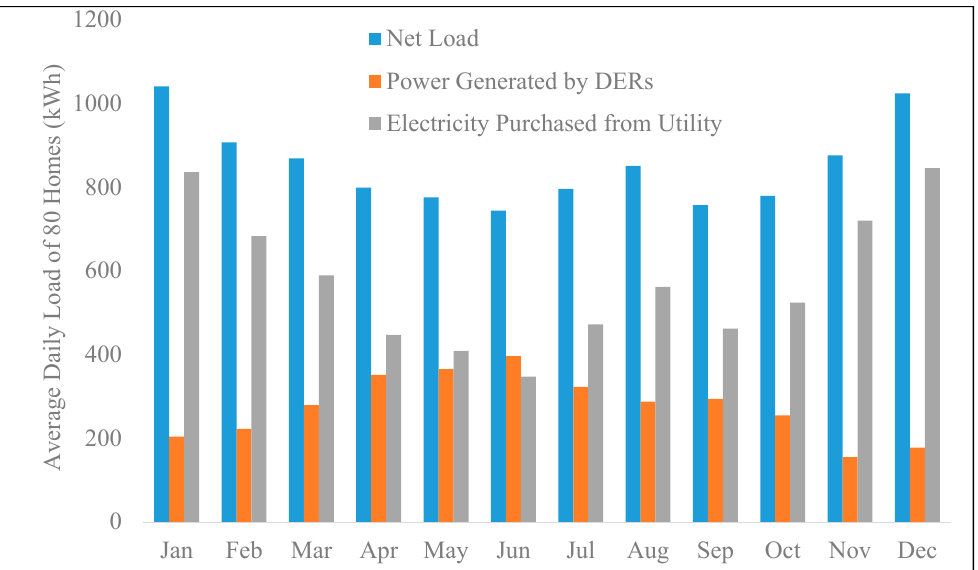
Figure 20. Average daily power generated by DERs and net load.